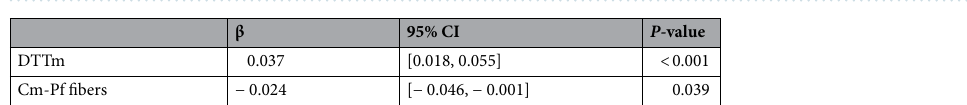
Figure 5. Effective stimulation configurations selectively activate thalamic pathways. ( A ) Combined lead locations of all three NHPs in one coronal image with the two predominant fiber pathways: the DTTm in blue and the Cm-Pf fibers in orange. ( B ) Stimulation configurations across all animals grouped by those that had a positive effect on performance (left), no effect (middle), and a negative effect (right) and the normalized percentage of how many configurations in that group activated the fibers in each pathway. 100% means that every configuration in the effect group activated that specific fiber, and 0% means that no configuration in that group activated that specific fiber. Nearly every stimulation configuration in the positive effect group activates nearly every fiber in the DTTm while activating minimal Cm-Pf fibers. The no effect group and the negative effect groups had reduced percentages of configuration activation of the DTTm and increasing activation of the Cm-Pf fibers.